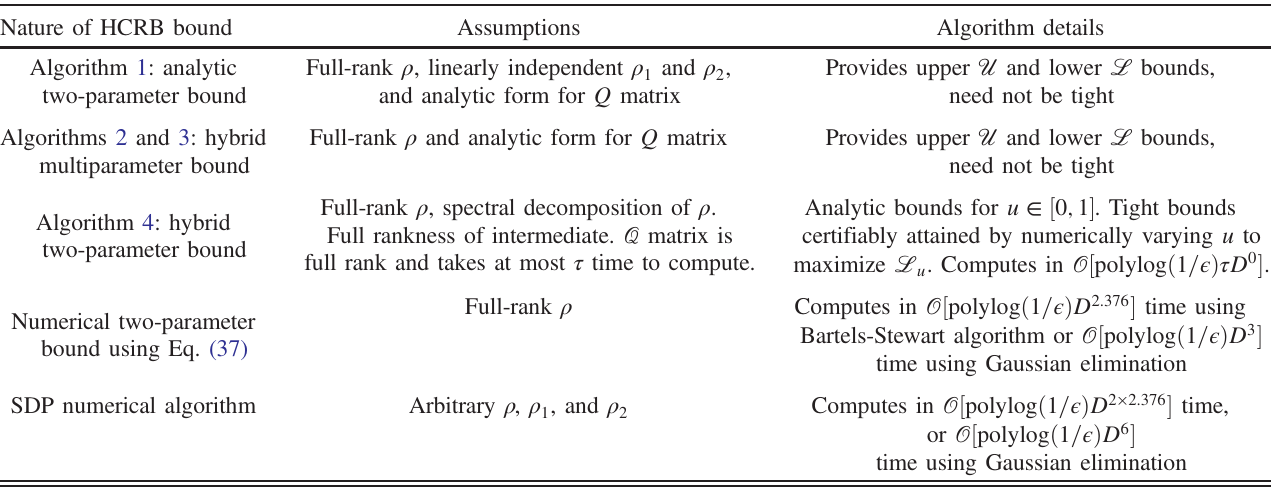
TABLE I. Algorithms and bounds to the HCRB for two and more parameters. Bounds are analytic, numerical, or a hybrid of analytical and numerical, as indicated in the first column. There is a trade-off between the assumptions taken for each algorithm and its complexity. Here, D is the dimension of the probe state, and ϵ a measure of how close the HCRB bound is to optimal. The final row provides comparative details for the SDP approach in Ref.